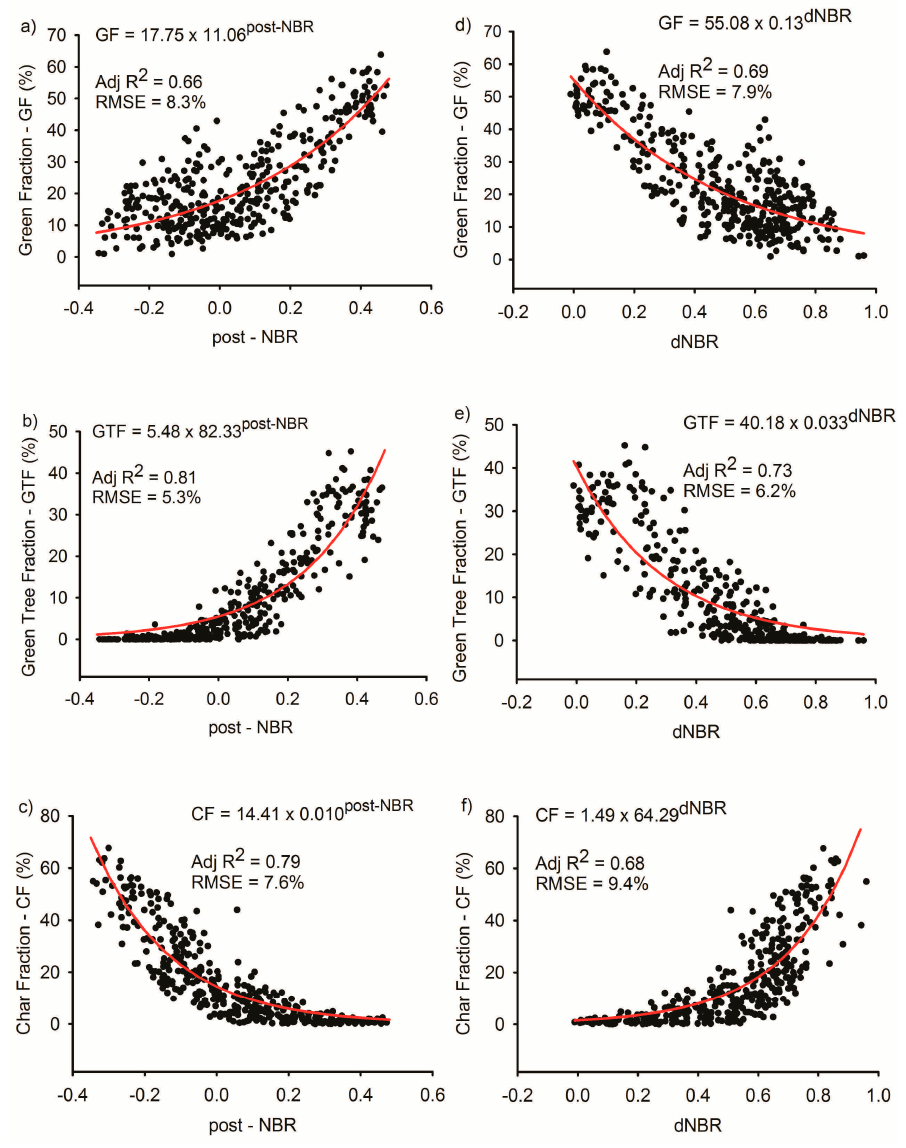
Figure 4. Scatterplots showing the relationships between the post-NBR and dNBR Landsat severity indices ( x -axes) and three UAV-based severity indicators ( y -axes), aggregated within the 30 m resolution Landsat pixel footprints. The best-fit exponential regression lines and equations are also shown for each relationship. The individual plots are post-NBR vs. green fraction ( a ), post-NBR vs. green tree fraction ( b ), post-NBR vs. char fraction ( c ), dNBR vs. green fraction ( d ), dNBR vs green tree fraction ( e ), and dNBR vs. char fraction ( f ).